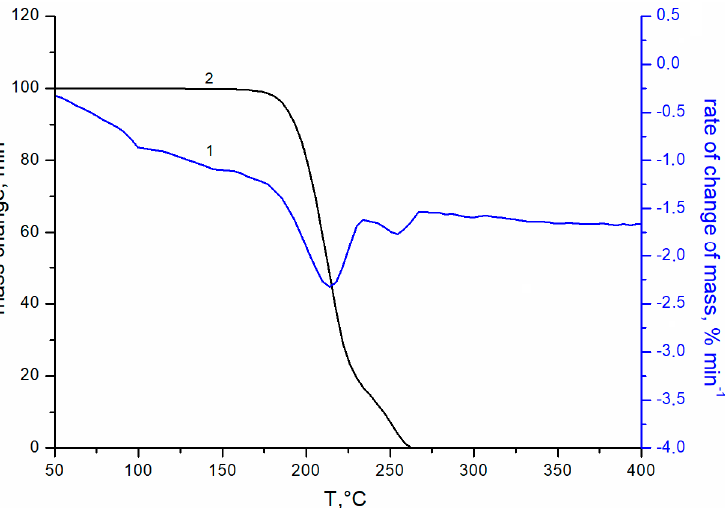
Figure 2. TGA curves of TBAB addition: 1—integral curve; 2—differential curve; heating rate 5 deg min − 1 , flow rate 80 mL min − 1 in an air atmosphere.